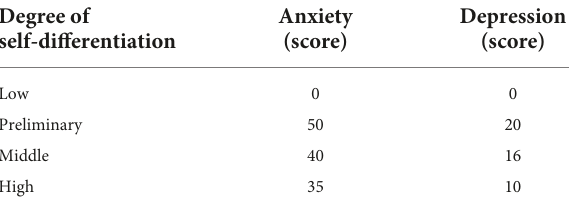
TABLE 1 Self-differentiation scores at different